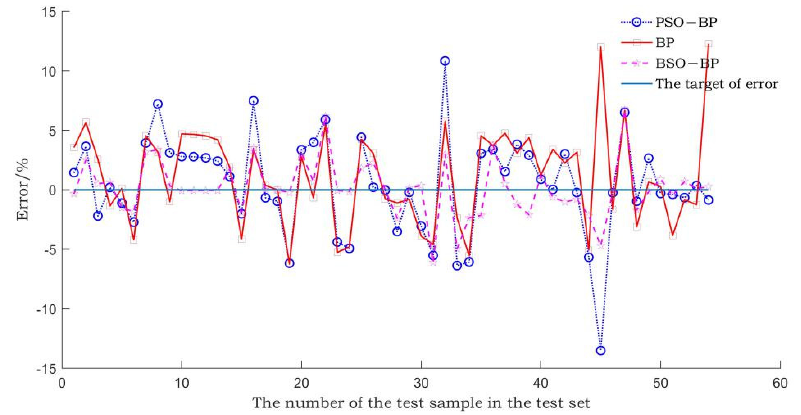
Figure 9. Comparison of axle weight prediction errors of different models.